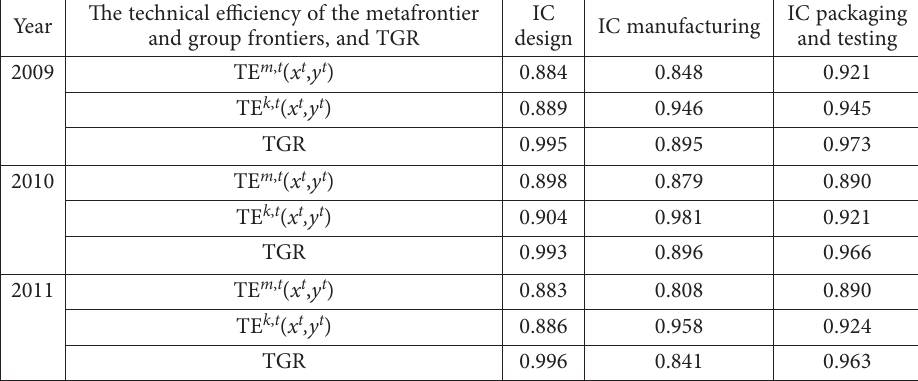
Table 4. The average technical efficiency of the metafrontier and group frontiers, and